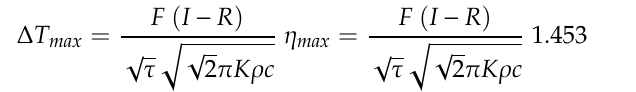
Table 3. Relation between laser pulse duration, fluency and heat diffusion length (HDL).